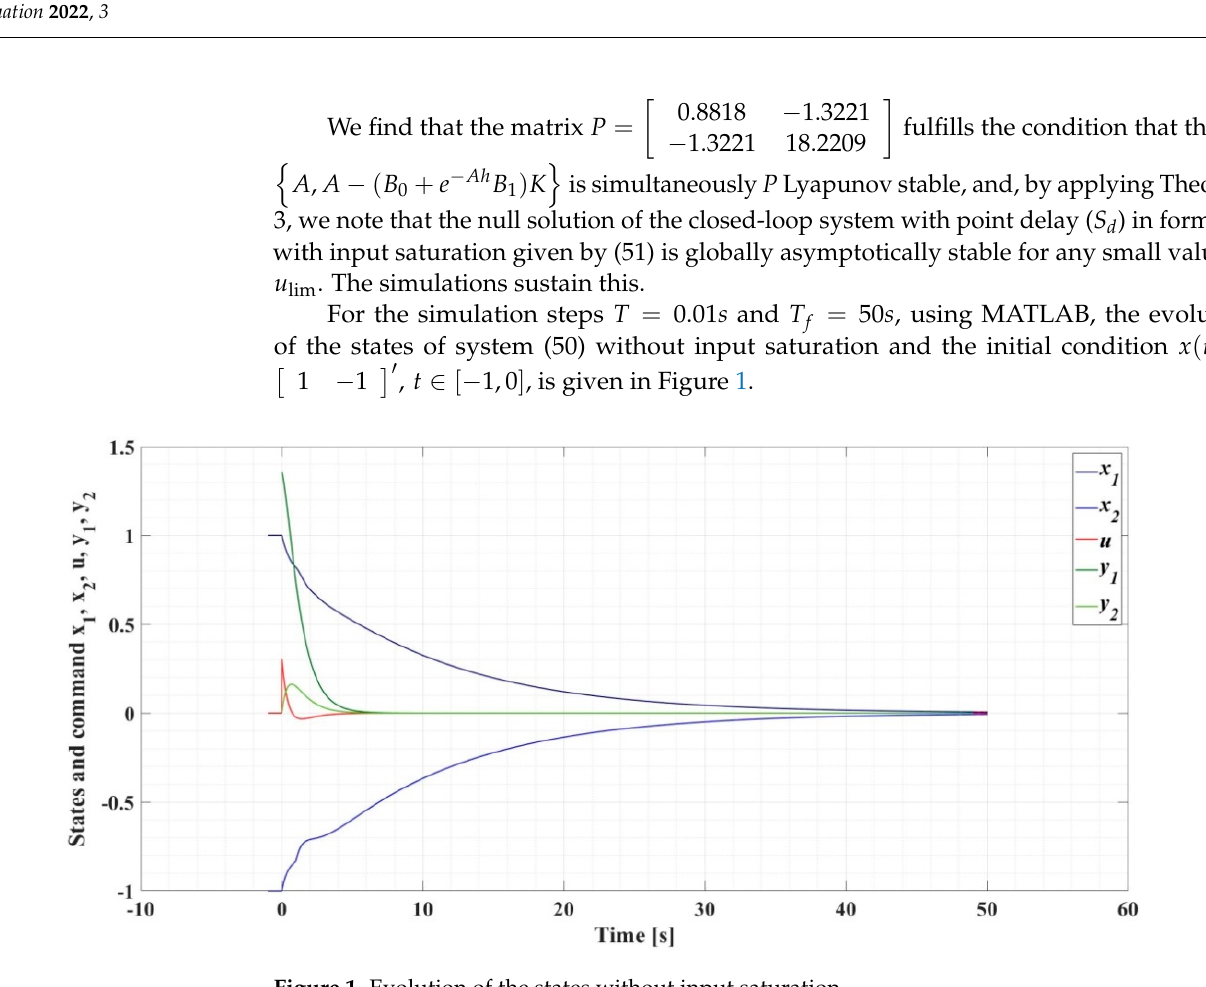
Figure 1. Evolution of the states without input saturation.